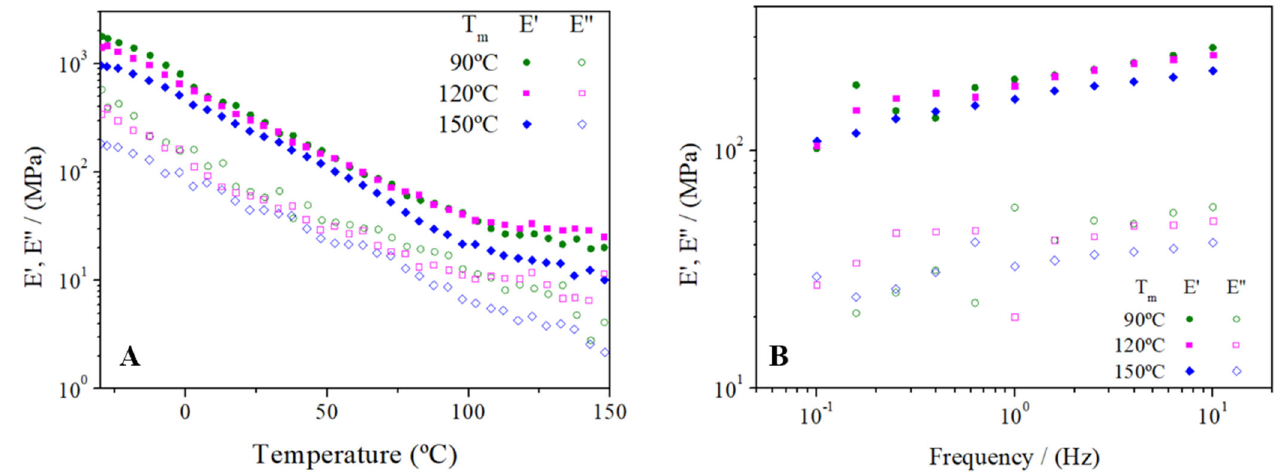
Figure 8. Dependence of viscoelastic moduli on temperature ( A ) and frequency ( B ) for RO/GLY 70/30 bioplastics processed at different molding temperature (90, 120 and 150 °C).